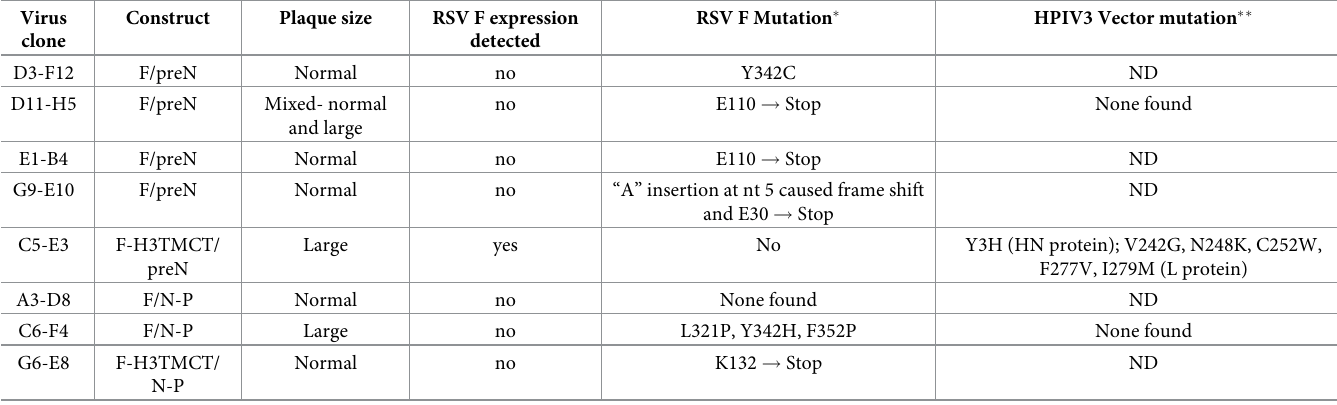
Table 1. Mutations detected in examples of viruses showing large plaques and/or loss of RSV F expression. Virus